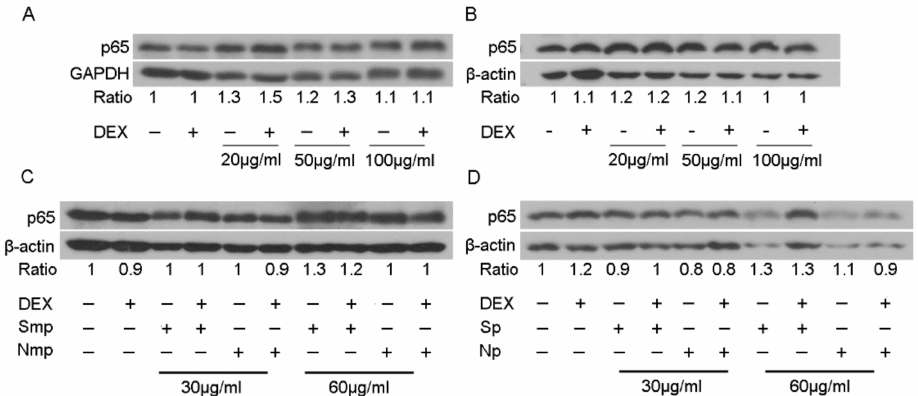
Figure 7. Regulation of the p65 protein levels by medium-polar ( A , C ) and polar ( B , D ) leaves fractions from south ( A , B ) and south versus north ( C , D ) Chios mastiha tree. Western blot analysis of p65